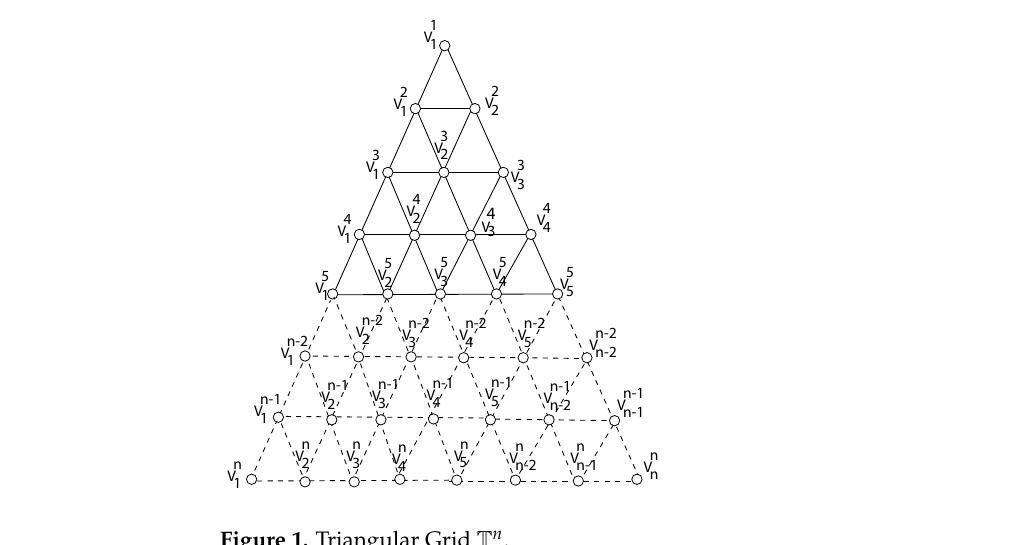
Figure 1. Triangular Grid T n .